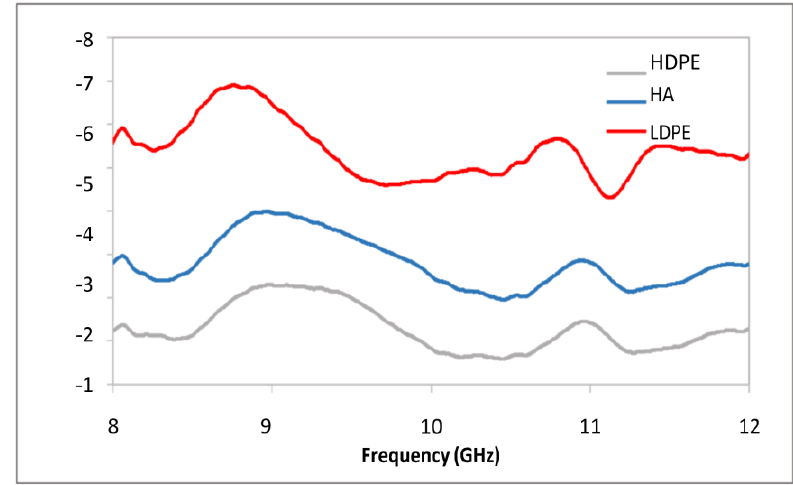
Figure 12. EMSE due to absorption of HDPE /PE composites in X band.